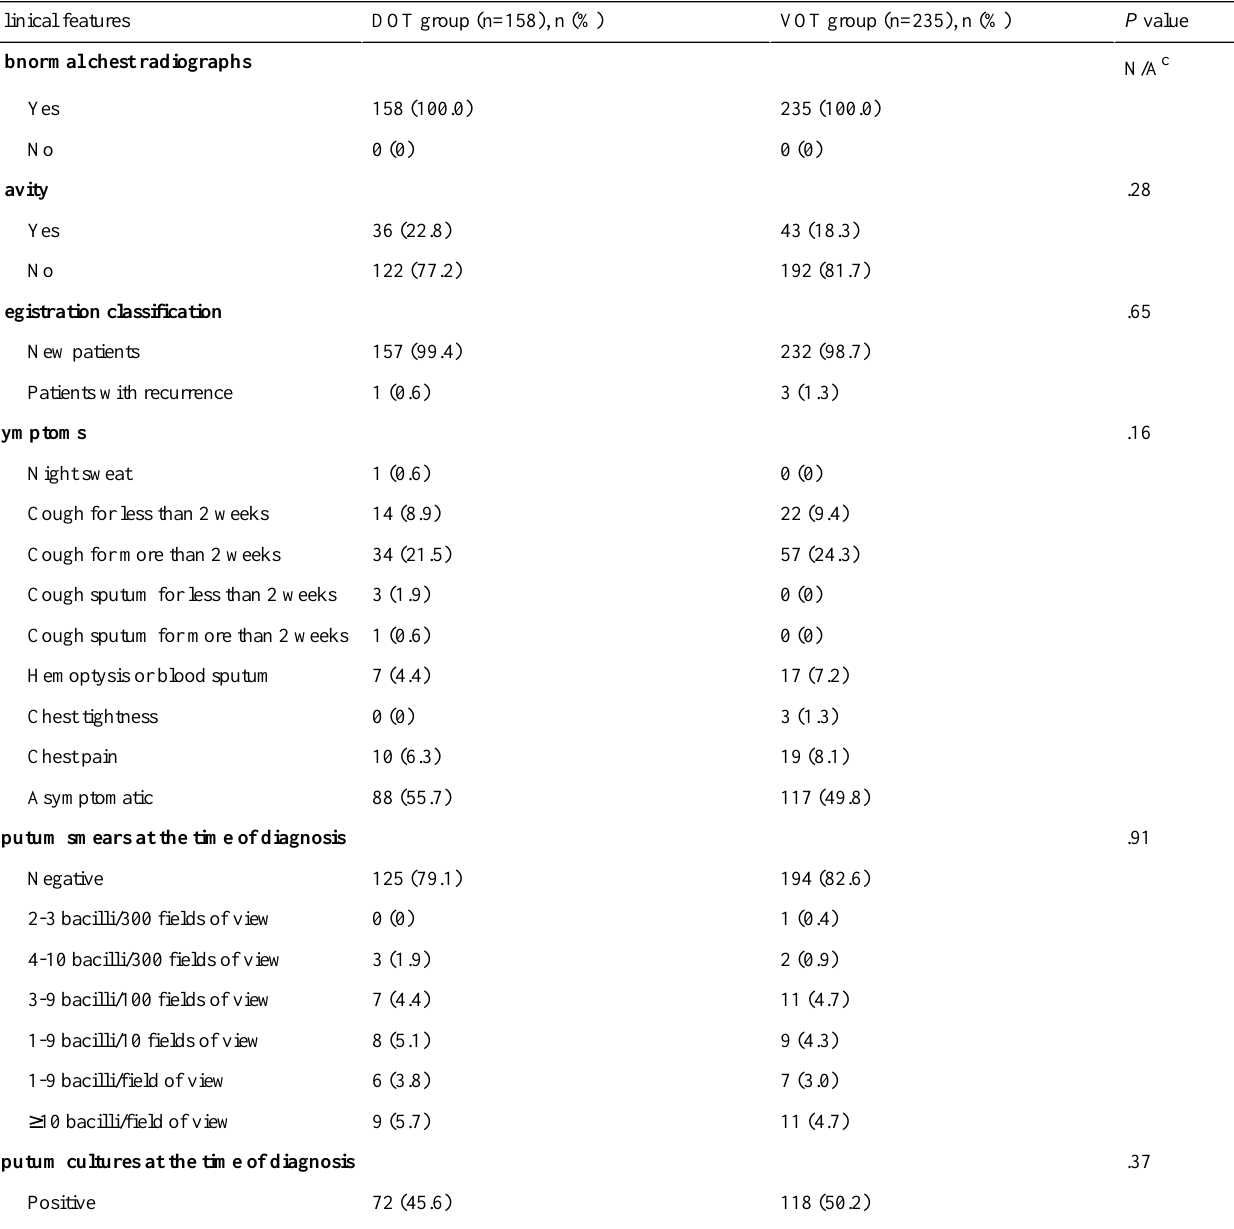
Table 2. Clinical features of the patients in the DOT a and VOT b